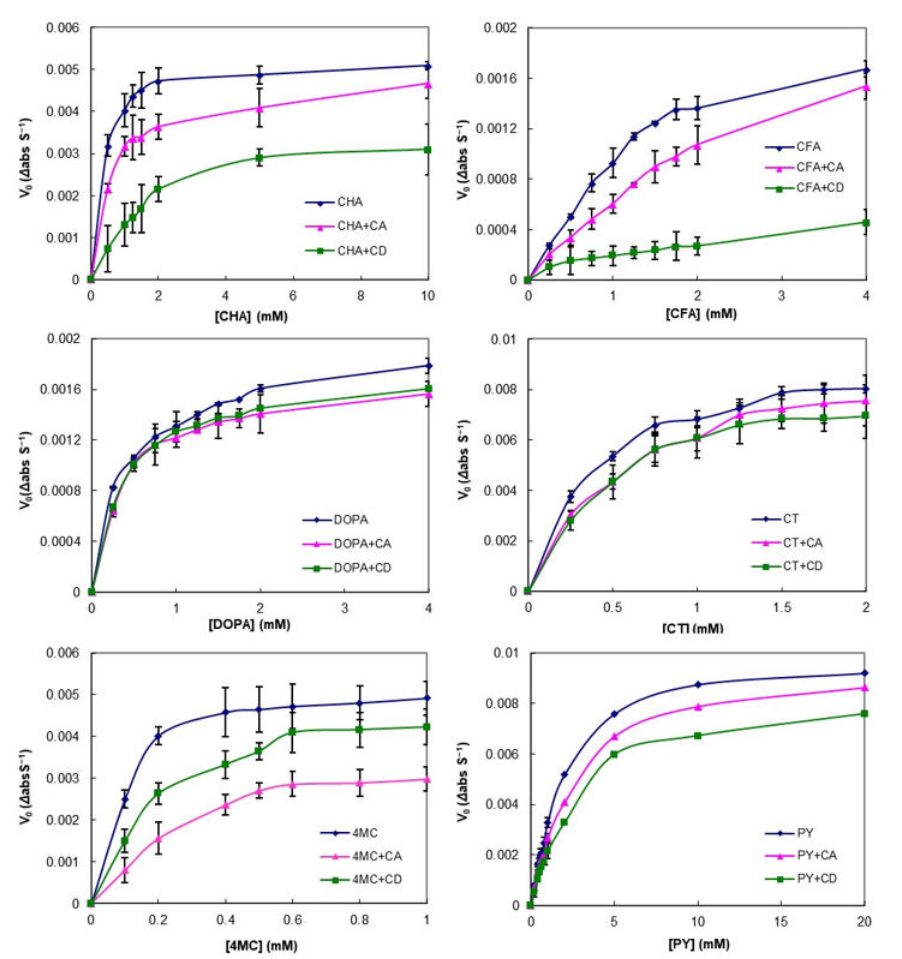
Figure 3. Effect of cyclic glucans (cycloamylose (CA) and cyclodextrin (CD)) on phenolic compounds (CHA, chlorogenic acid; CFA, caffeic acid; DOPA, 3,4-Dihydroxy- L -phenylalanine; CT, catechol; 4MC, 4-methylcatechol; PY, pyrogallol) oxidation catalyzed by polyphenol oxidase (PPO). Symbols repre- sent experimental data ( ± SEM). Lines were the Michaelis–Menten curves fitted to the experimental data. The error bars indicate standard deviation ( n = 3) and statistically significant differences based on Tukey’s test ( p <